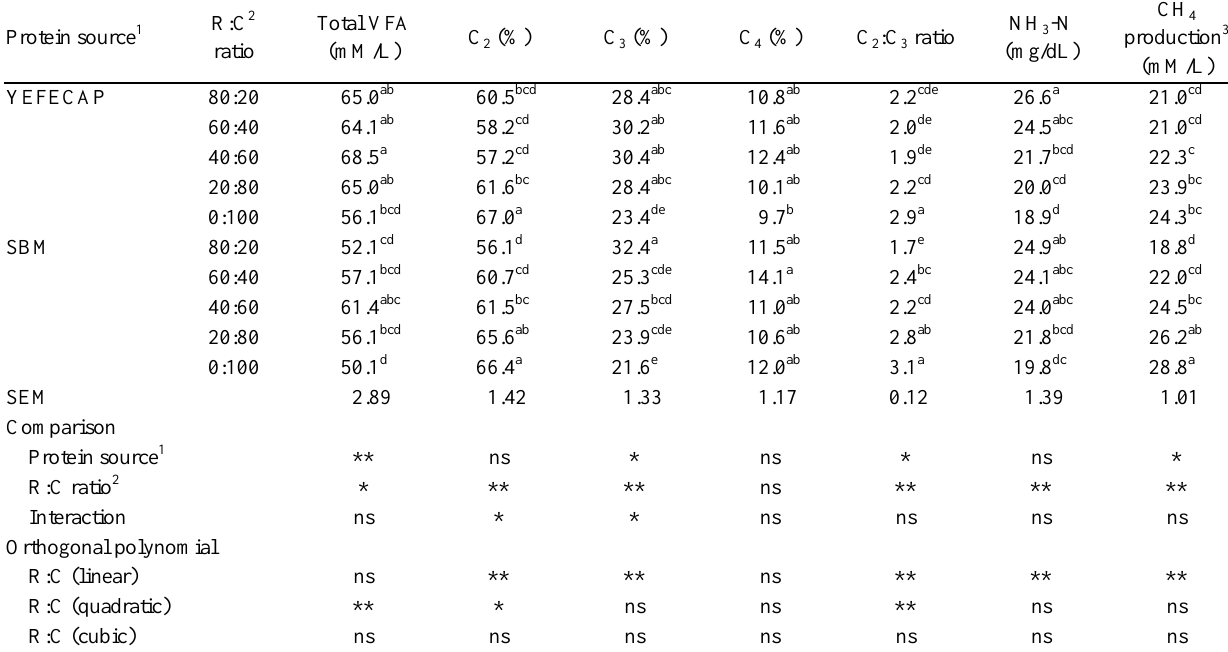
Table 3. Effect of protein source with roughage to concentrate ratio on in vitro volatile fatty acids (VFA), ammonia nitrogen (NH 3 -N) and methane production (CH 4